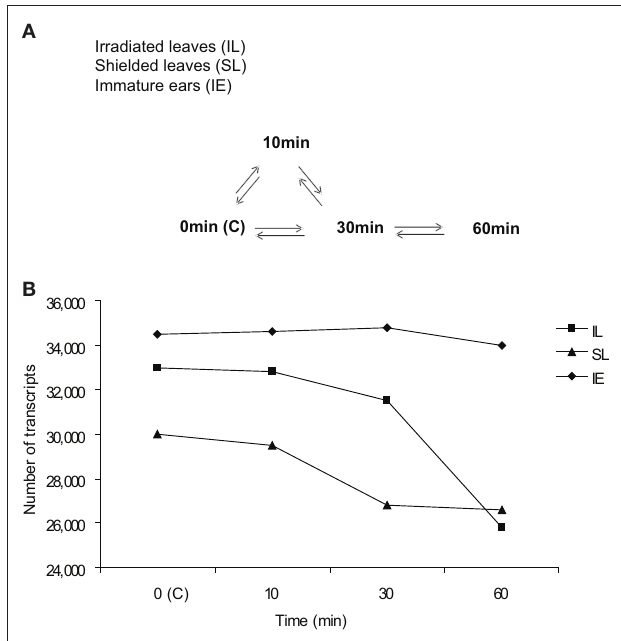
FigURe 1 | Microarray design and transcriptome size in UV-B-irradiated and shielded leaves and immature ears after different UV-B irradiation times. (A) Microarray hybridization design with direct comparisons to measure UV-B effects on signaling initiation from irradiated (irradiated leaves, IL) to shielded tissues (shielded leaves, SL; and immature ears, IE). All time course treatments had two leaves exposed above the PE. Each arrow represents a pair of samples hybridized on one array; in every case there is one cy3-labeled sample compared to one cy5-labeled sample. For each sample type there were four biological replicates, generating at least four hybridization comparisons, except where noted. No UV-B irradiation or